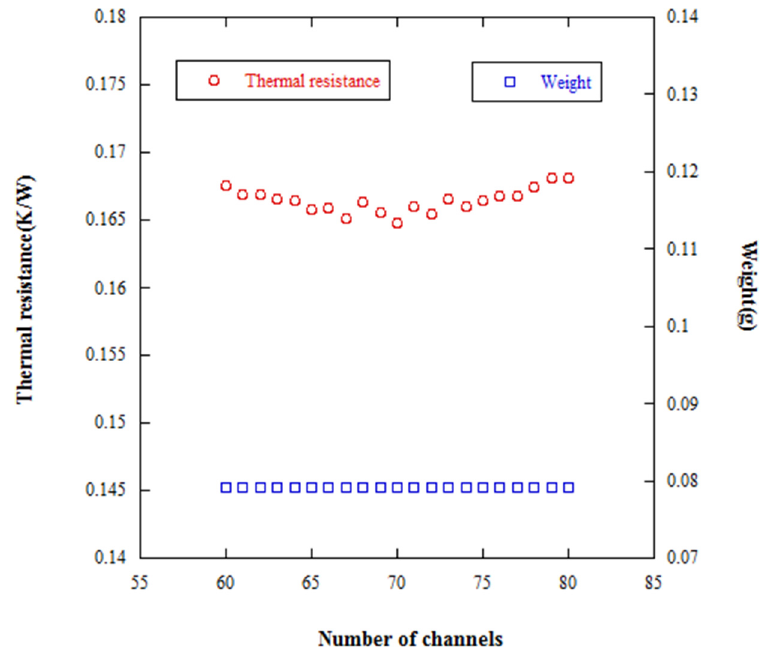
Figure 10. Variation of thermal resistance with the minimum weight of the micro channel heat sink.